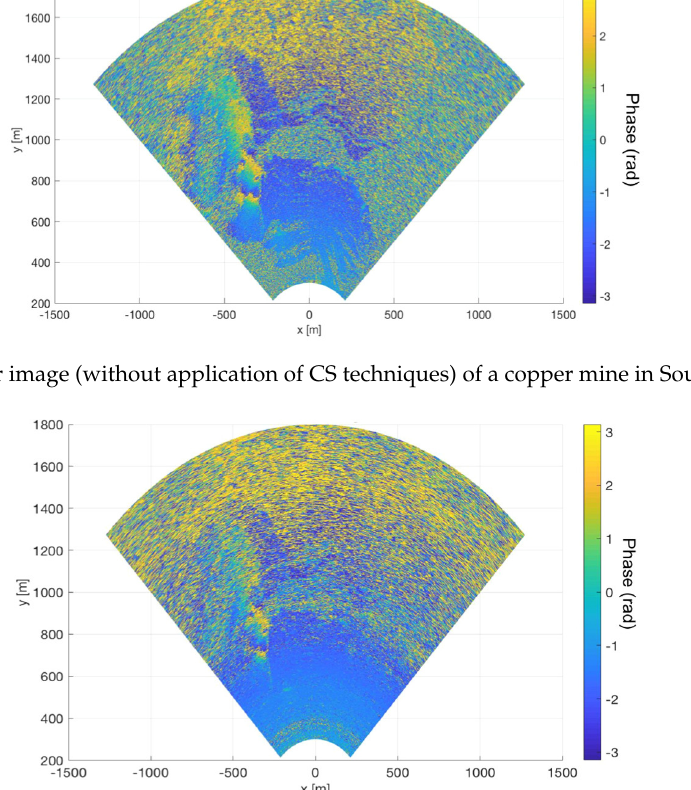
Table 3. PSNR calculated with different bases and recovery methods for experimental data acquired at a copper mine in South America